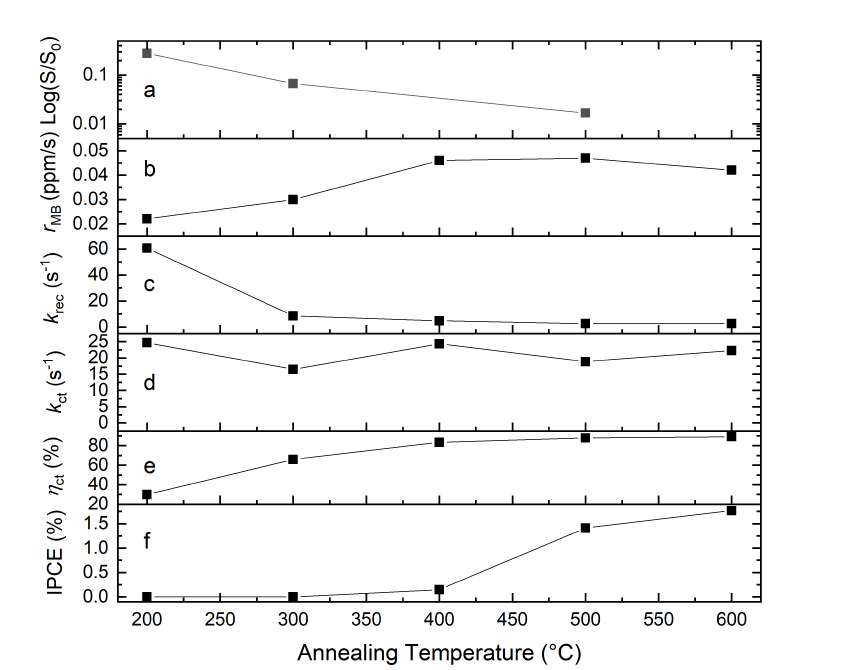
Figure 2. Comparison of photocatalytic and photoelectrochemical parameters of TiO 2 films annealed at different temperatures on FTO glass under UV-A irradiation: ( a ) E. coli survival rate after 60 min irradiation (please note, that the data point at “200 ◦ C” denotes here an uncoated glass reference sample), ( b ) methylene blue degradation rate, ( c ) charge carrier recombination rate, ( d ) charge transfer rate, ( e ) charge transfer efficiency, and ( f ) photoquantum yield IPCE (incident photon conver- sion efficiency). The electrochemical parameters were determined at a potential of approximately − 0.6V Ag/AgCl . (Reprinted/adapted with permission from Ref. [44]). More information can be found in Ref.